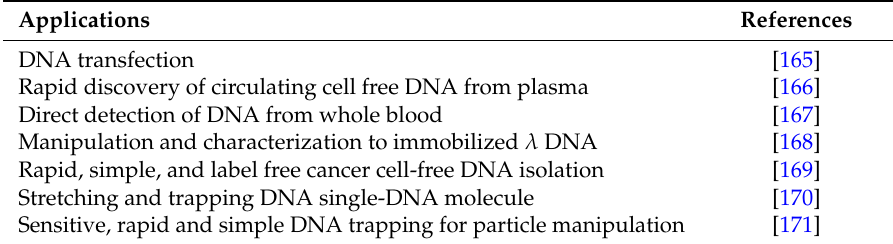
Table 8. DEP investigations of